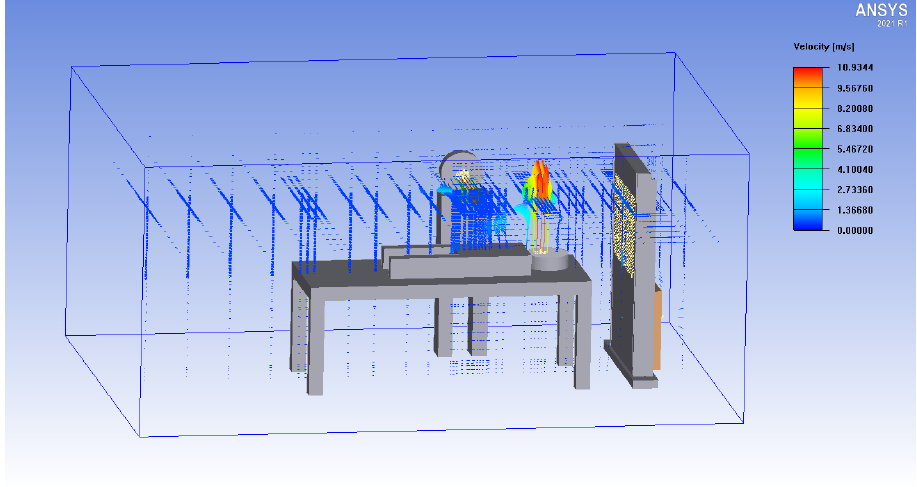
Figure 22. Air purifier top-view simulation in the ward at a low rotation speed -1.